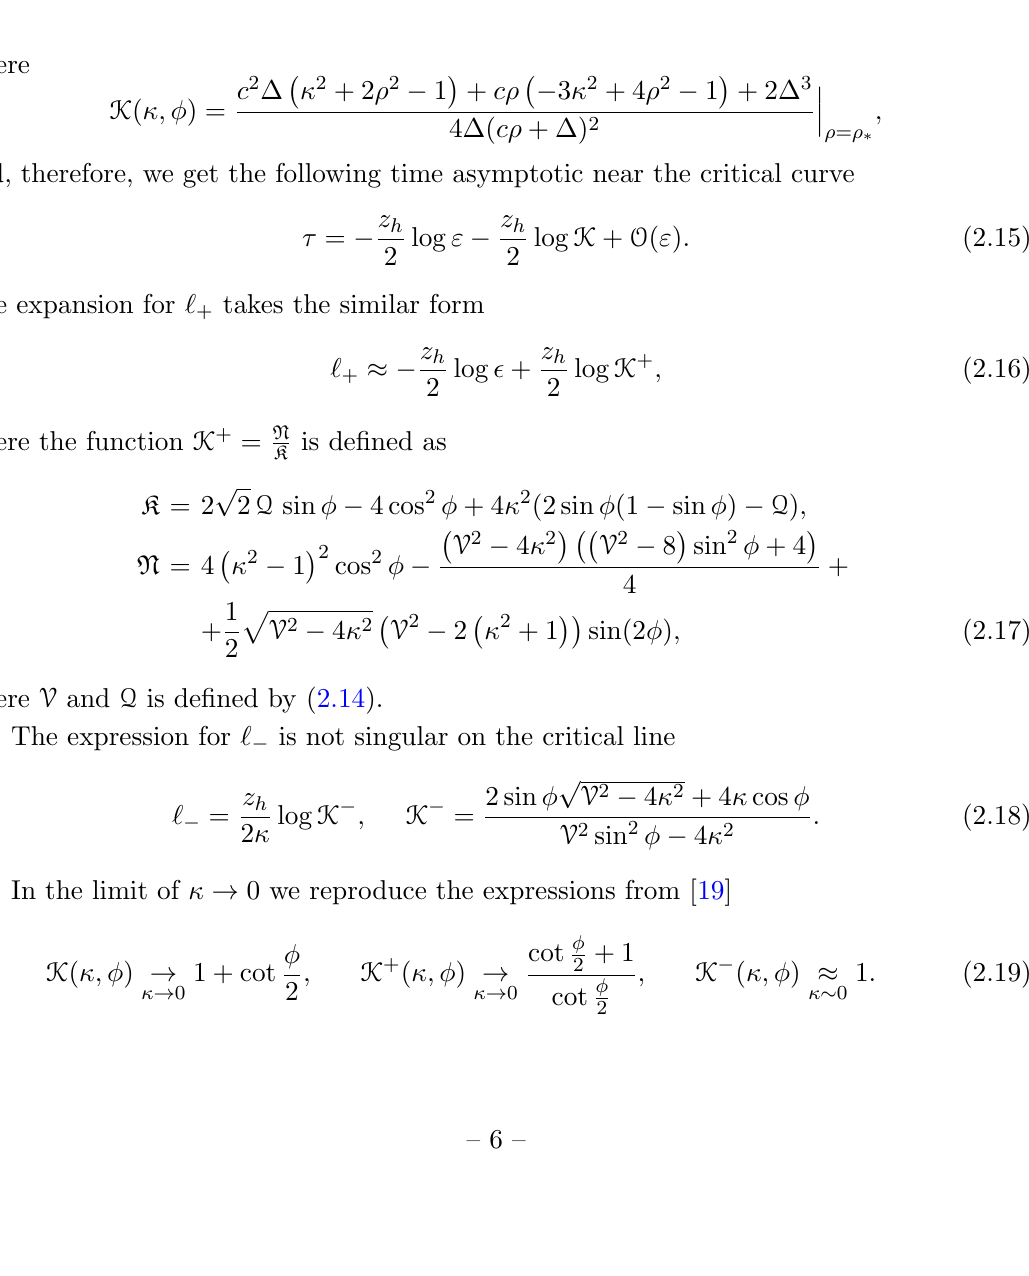
Figure 2 . The contour plots for ‘ and (cid:28) as functions of (cid:26) and (cid:30) for di(cid:11)erent (cid:20) = 0 and (cid:20) = 0 : 667. These plots show that on the right of the critical line (the darker red line) for ‘ > (cid:28) we can always (cid:12)nd solution to the system of equations: (cid:28) = (cid:28) ( (cid:26); (cid:30) ); ‘ = ‘ ( (cid:26); (cid:30) ). Lines of the equal times (cid:28) = 0 : 7 ; 1 ; 1 : 5 ; 2 ; 2 : 5 in all panels are shown by blue color with increasing thickness from right to left. Lines of the equal ‘ = 0 : 7 ; 1 ; 1 : 5 ; 2 ; 2 : 5 in all panels are shown by brown with increasing thickness from up to